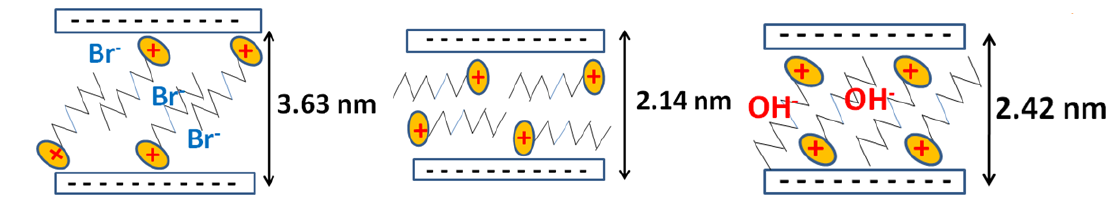
Figure 7. Illustrations of the structure of different organo-clays. Table 3. The basal spacing values of OCs and possible arrangement of the intercalated C16TMA cations. Uploaded Amount d 001 (nm) Interlayer Spacing